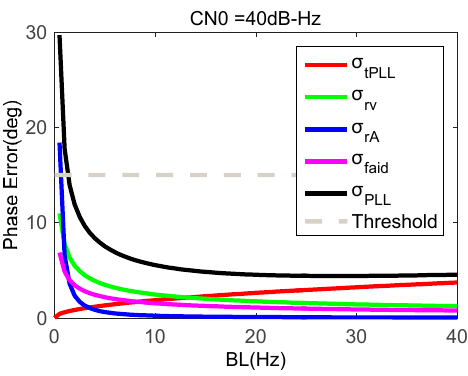
Figure 7. Phase errors of MEMS accelerometer-aided PLL with a carrier-to-noise ratio (CN0) of 40 dB-Hz.